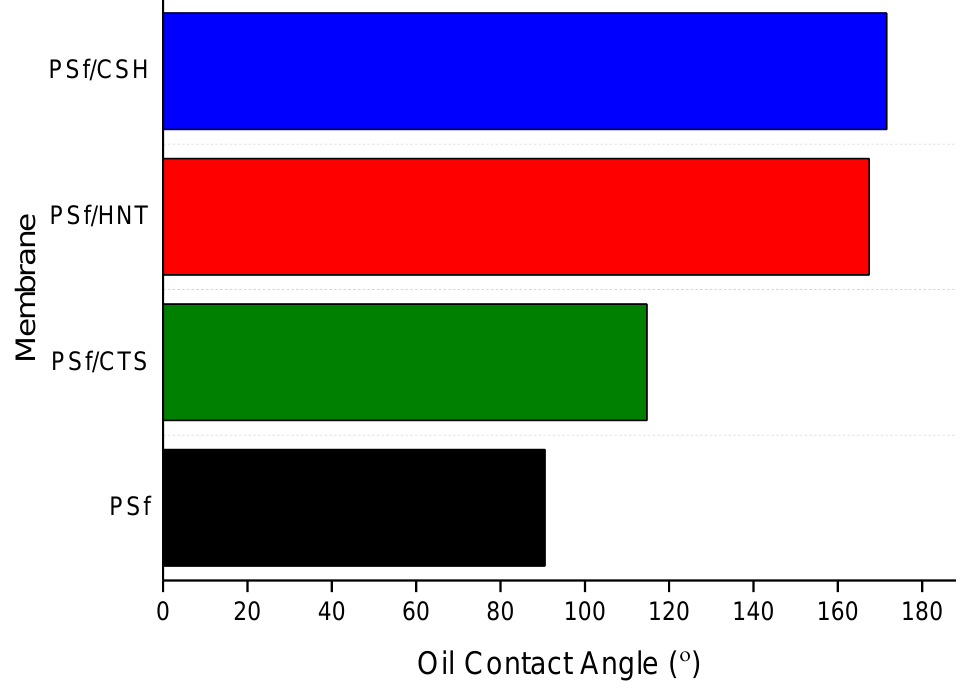
Figure 11. OCA for membranes incorporated with different types of nanocomposites.